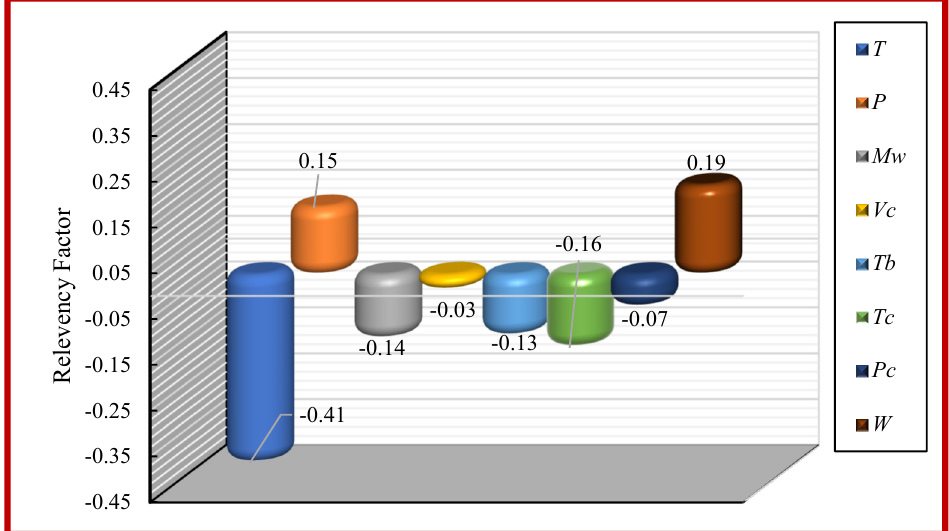
Figure 17. Relevancy factor of the CMIS model inputs based on Model (II).